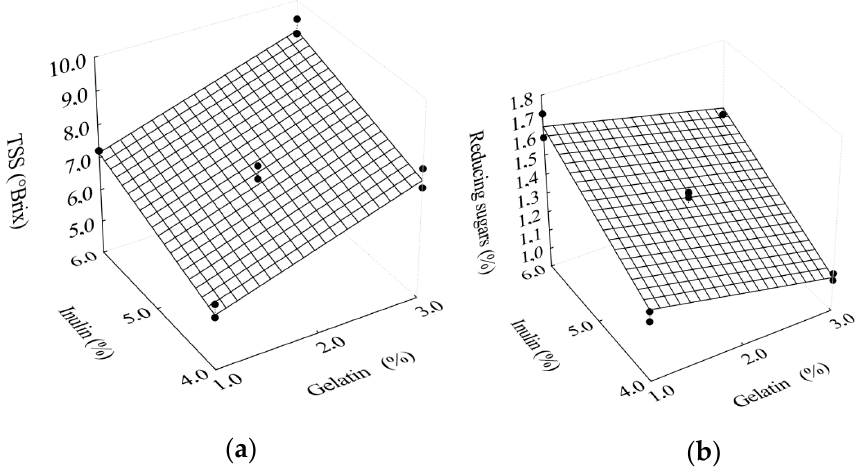
Figure 4. Response surfaces for the effects of gelatin and inulin concentrations as a function of ( a ) total soluble solids; ( b ) reducing sugars. ( a ) total soluble solids; ( b ) reducing